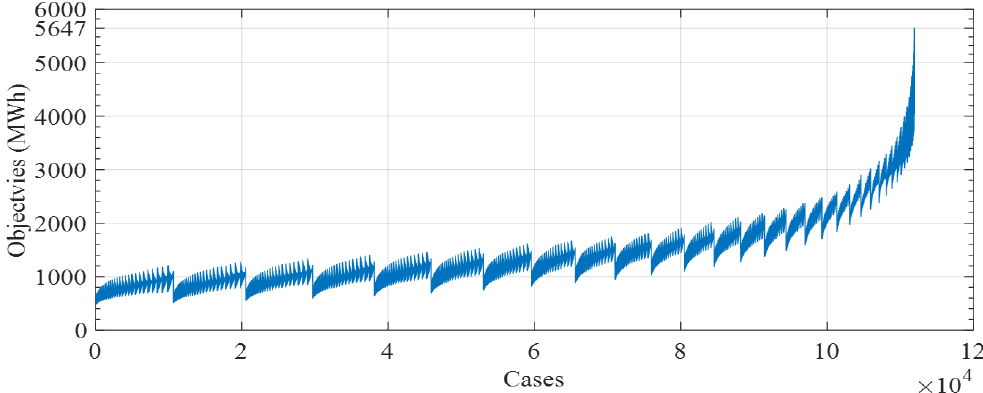
Figure 17. Global optimum search within all feasible combinations.